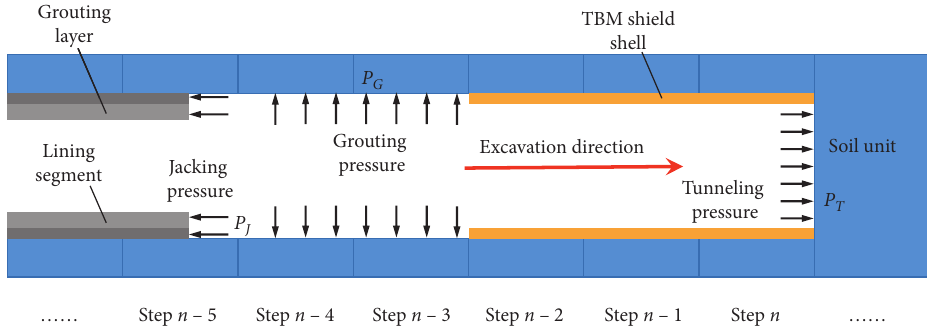
Figure 4: Diagram of TBM construction numerical simulation